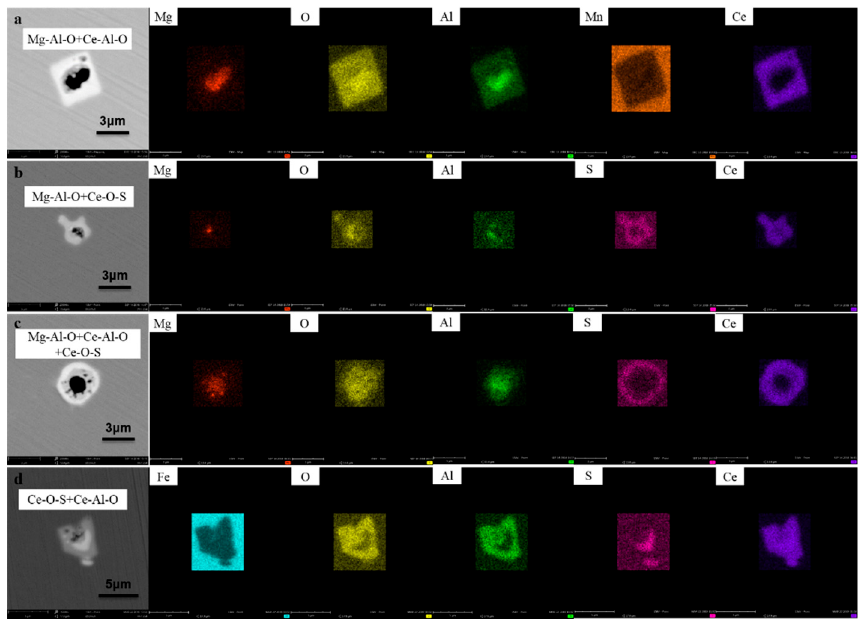
Figure 3. Elemental mapping of typical complex inclusions: ( a ) Mg-Al-O + Ce-Al-O; ( b ) Mg-Al-O + Ce-O-S; ( c ) Mg-Al-O + Ce-Al-O + Ce-O-S; ( d ) Ce-O-S + Ce-Al-O.